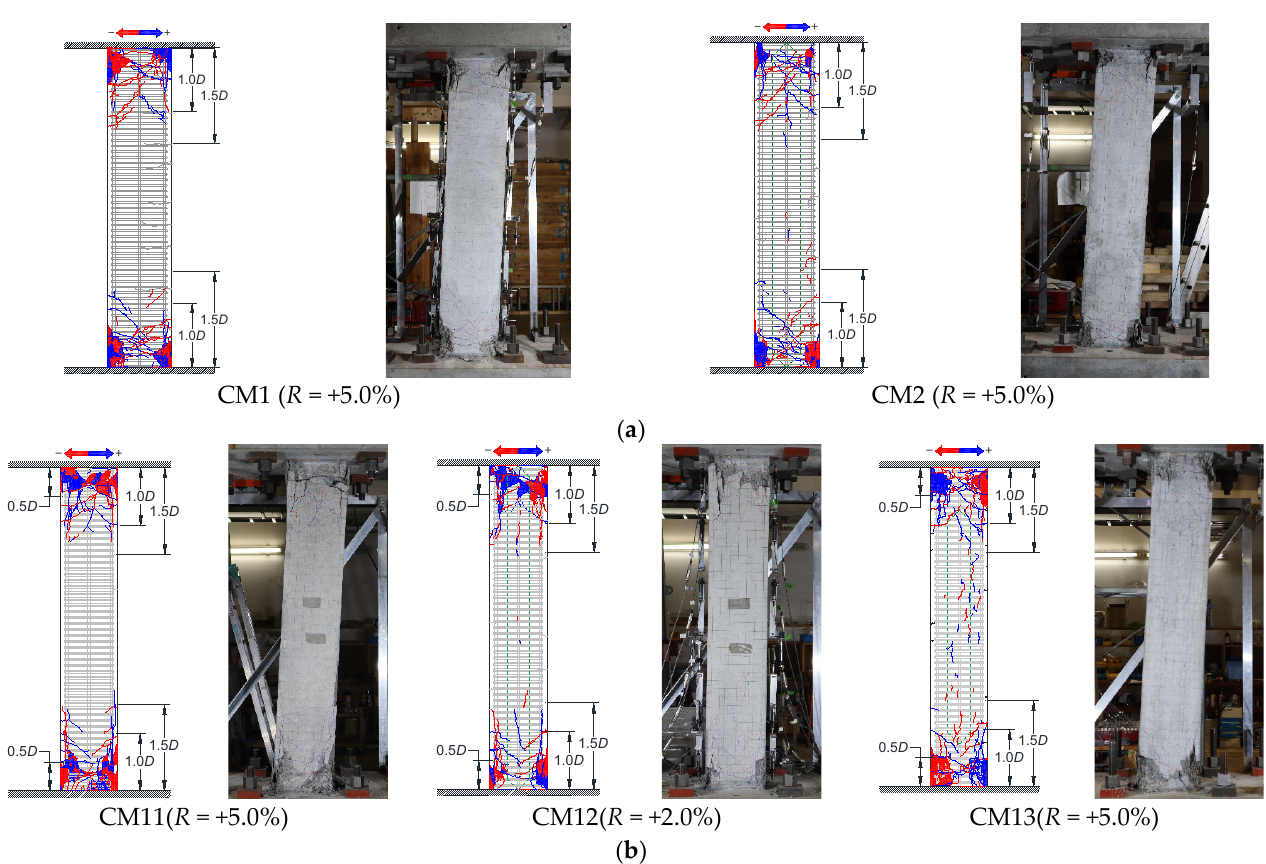
Figure 7. Crack patterns: ( a ) N-series; ( b ) S-series.